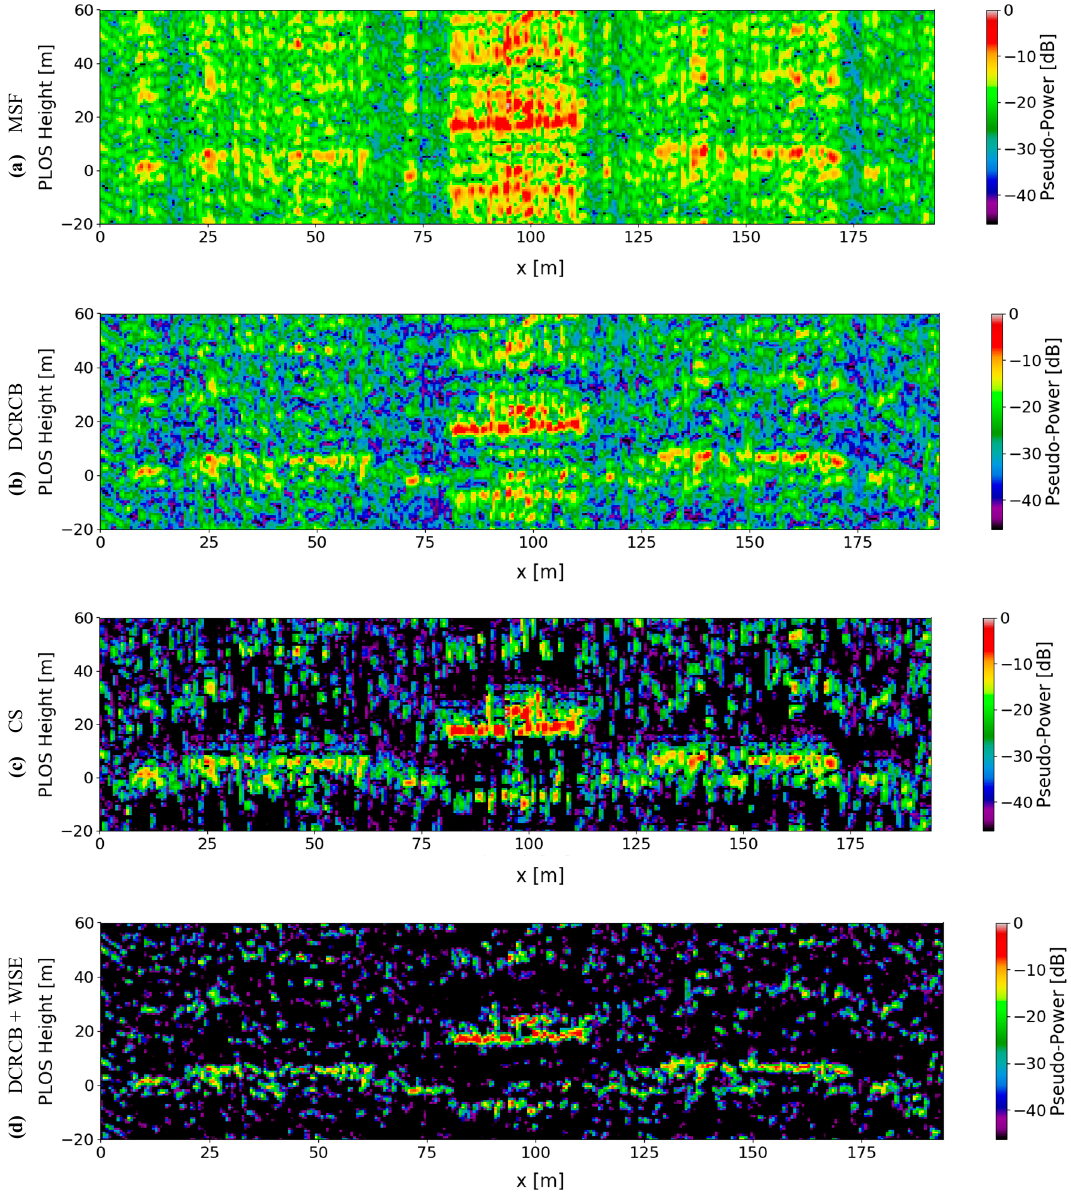
Figure 16. HV tomograms retrieved from the area depicted by the red line crossing the ROI specified in Figure 5. We perform focusing using ( a ) MSF, ( b ) DCRCB, ( c ) CS and ( d ) DCRCB + WISE. We refer to the single-look case. All tomograms are normalized with respect to the (pseudo) power recovered by MSF.